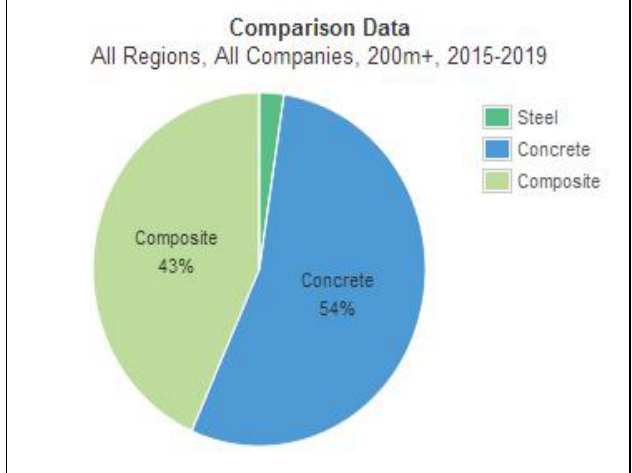
Figure 6. Comparison of material system applied in high-rise buildings (above 200 m) in the years 2015 – 2029 (on the basis of the global tall buildings database of CTBUH (Council on Tall Buildings and Urban